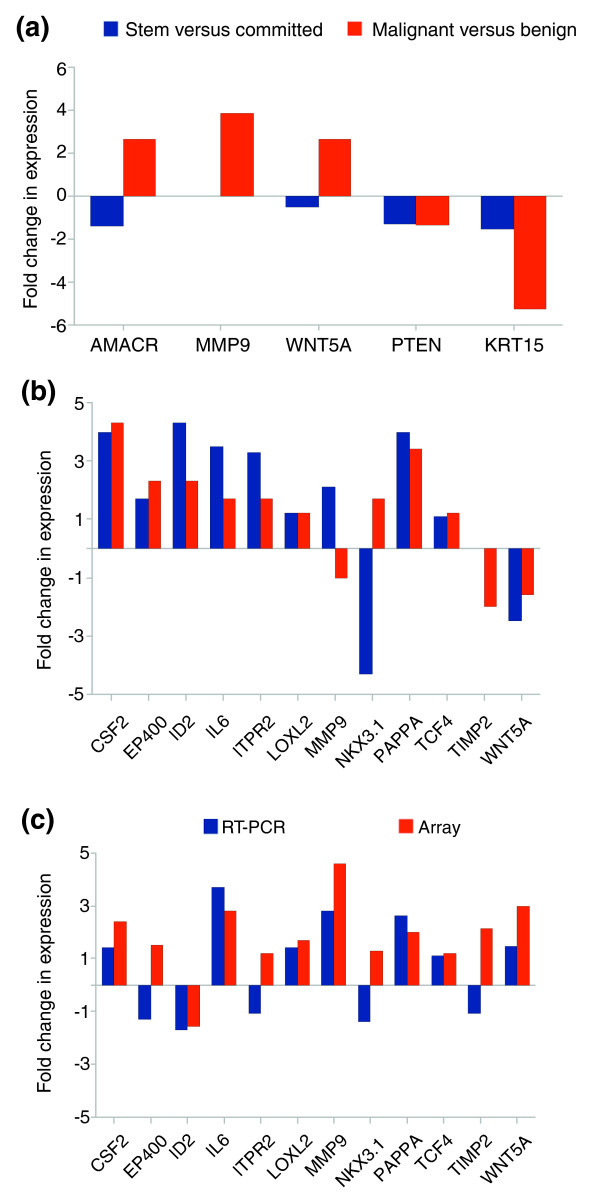
Validation of selected genes by quantitative real time PCR. (a) RT-PCR confirmation of Affymetrix array data on genes associated with prostate cancer (all changes in expression were significant at p < 0.05). Changes between stem and committed cells are indicated in blue, while malignant versus benign changes are indicated in red. (b) Validation of average changes in gene expression between stem and committed basal populations detected by Affymetrix array (red bars) and RT-PCR techniques (blue bars). (c) Validation of average changes in gene expression between malignant and benign stem cell populations detected by Affymetrix (red bars) and RT-PCR techniques (blue bars).